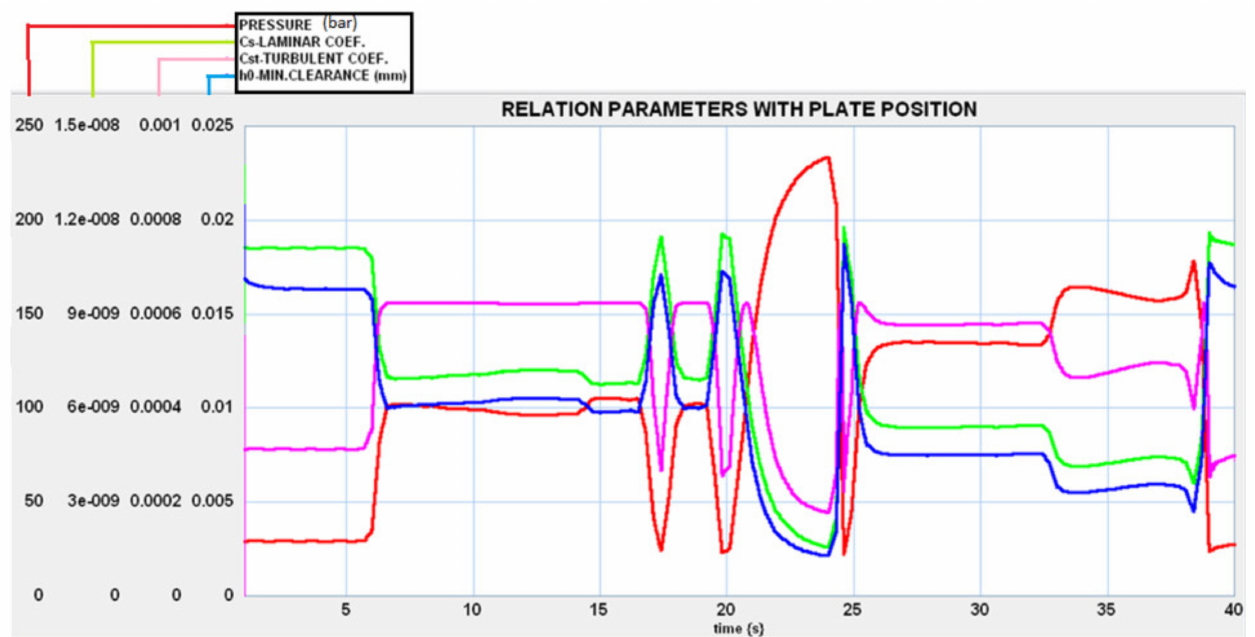
Figure 14. Leakage coefficients and minimum film thickness in a real jib cycle (1467